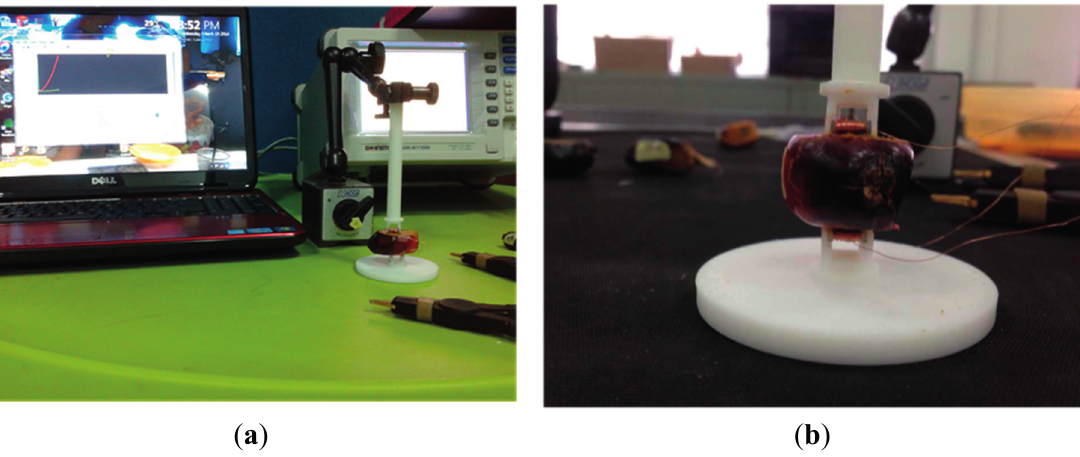
Figure 3. Samples preparation for the dual flat-type shape air coil. ( a ) Experimental setup, ( b ) Sample close up.